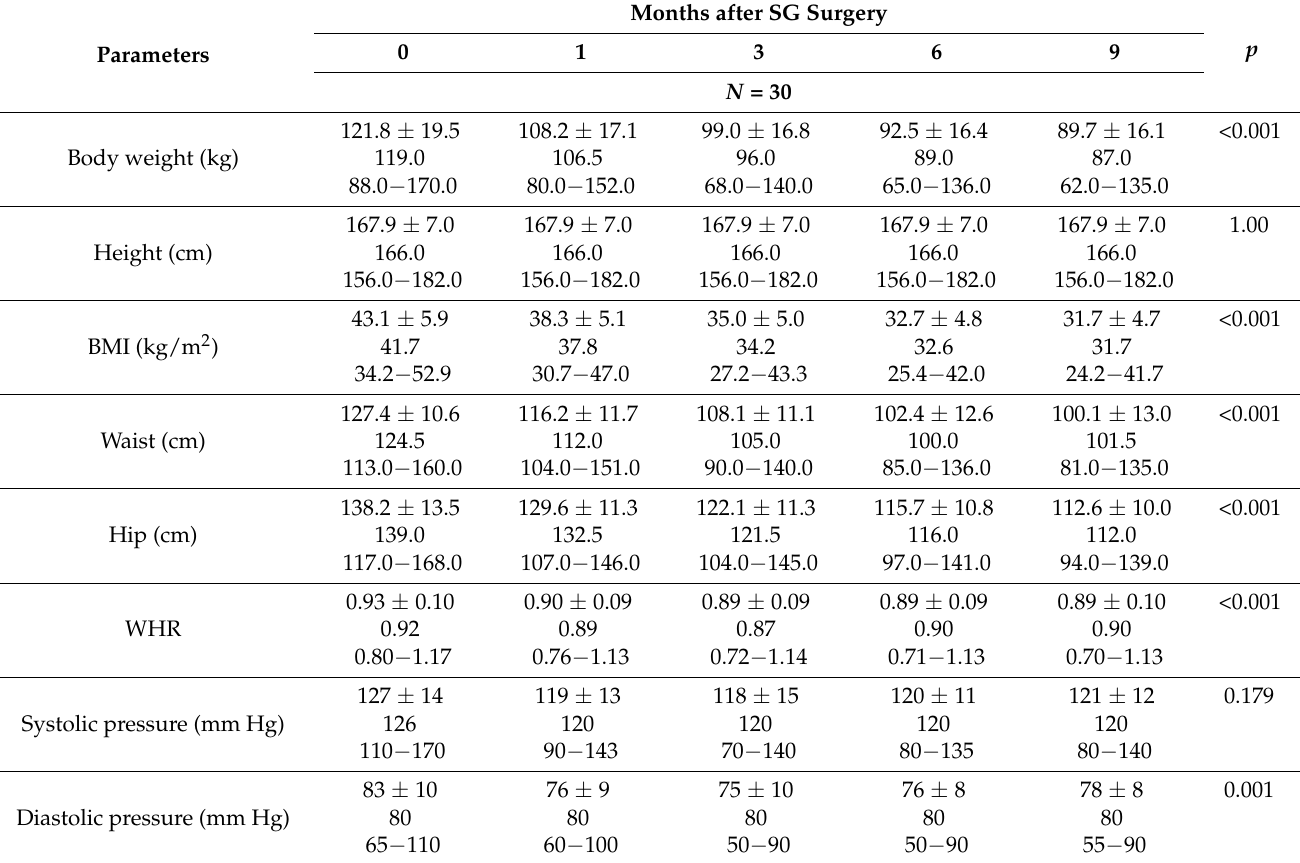
Table 3. Anthropometric and blood pressure measurements in patients within 9 months of therapy.